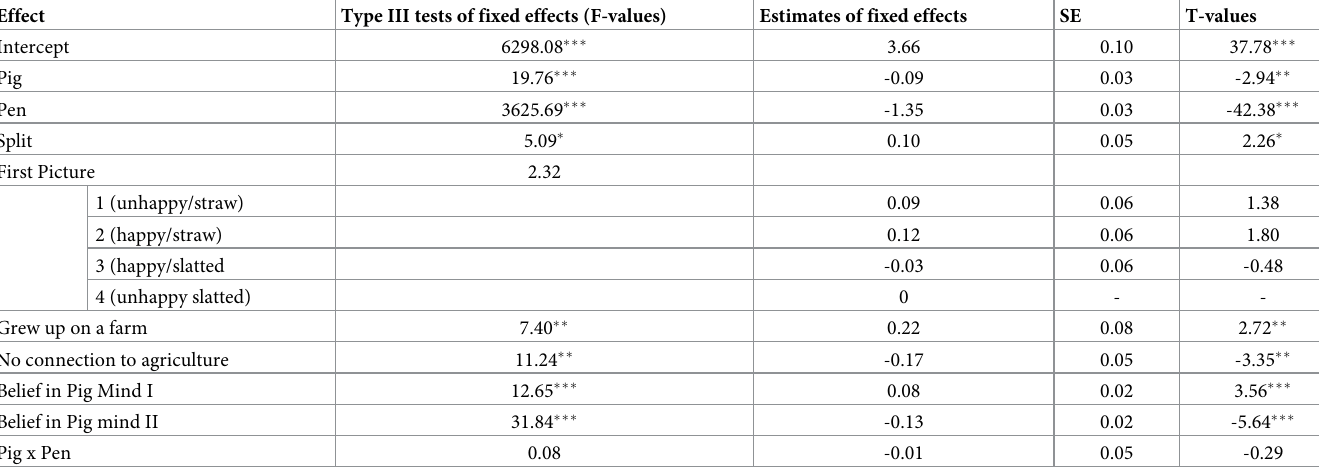
Table 7. Type III tests of fixed effects and estimates of fixed effects in the linear mixed model on pen evaluation in the pictures. Effect